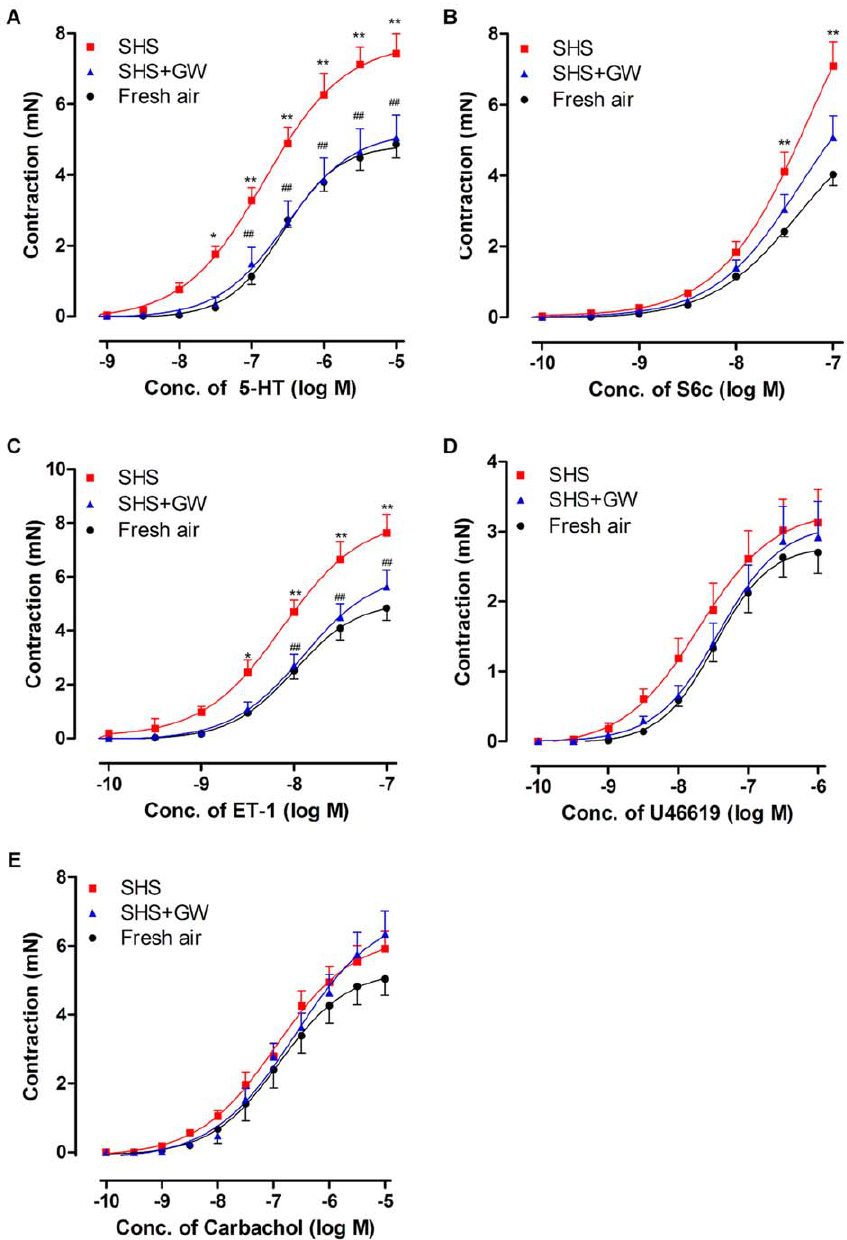
Figure 1. Contractile responses to the receptor agonists. The bronchial segments were from rats that were exposed to fresh air, SHS and SHS + GW5074. The response curves were induced by cumulative application of 5-HT (A), S6c (B), ET-1 (C), U46619 (D) and carbachol (E), respectively. The contractions are shown in absolute mN. The values are expressed as the mean 6 SEM ( n =8–10). The statistical analysis was performed using two-way ANOVA with Bonferroni’s post-test. * P , 0.05, ** P , 0.01 vs. fresh air exposure group; ## P , 0.01 vs. SHS exposure